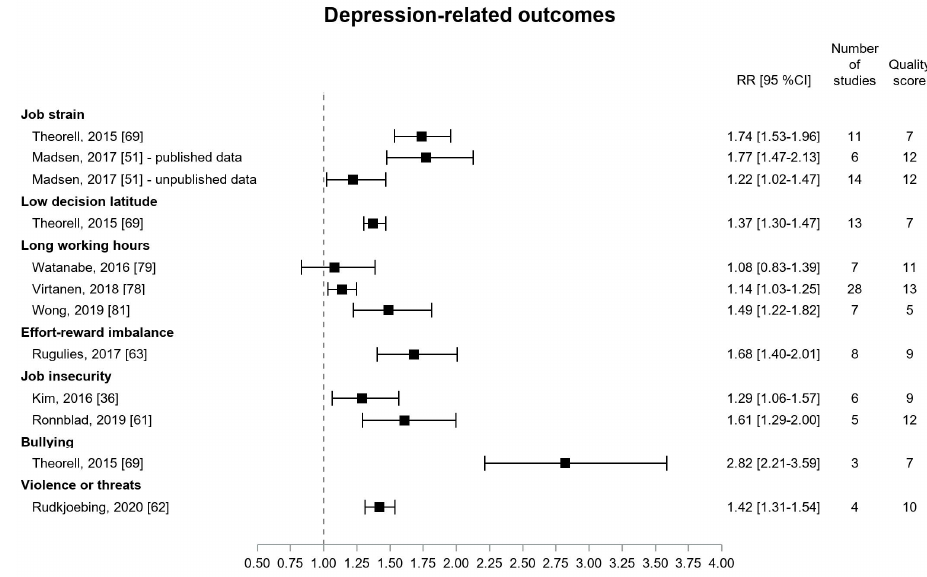
Figure 7. Pooled estimates for the associations between psychosocial work exposures and depression-related